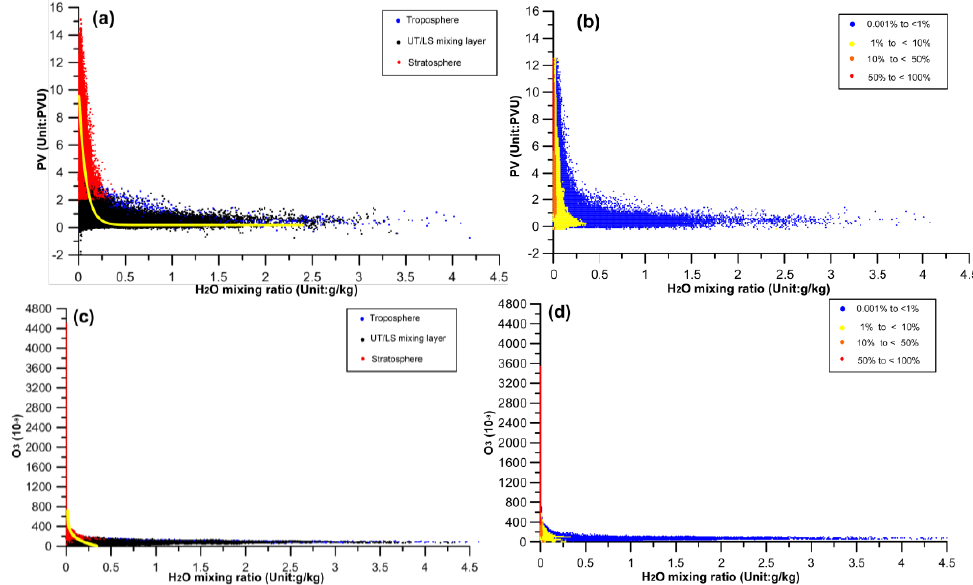
Figure 2 . ( a ) and ( b ) Distribution and occurrence probability of the isentropic general moist potential vorticity and moisture from upper troposphere (over 400hPa) to stratosphere; ( c ) and ( d ) same as ( a ) and ( b ) but for the ozone and moisture. (The red, blue and black points in figure ( a ) and ( c ) indicate air mass come from stratosphere, upper troposphere and mixing area between upper troposphere and lower stratosphere, the yellow curves are the fitting curves; The blue, yellow, orange and red points in figure ( b ) and ( d ) represent air masses occurrence probability lower than 1% and between 1%–10%, 10%–50% and over 50%).